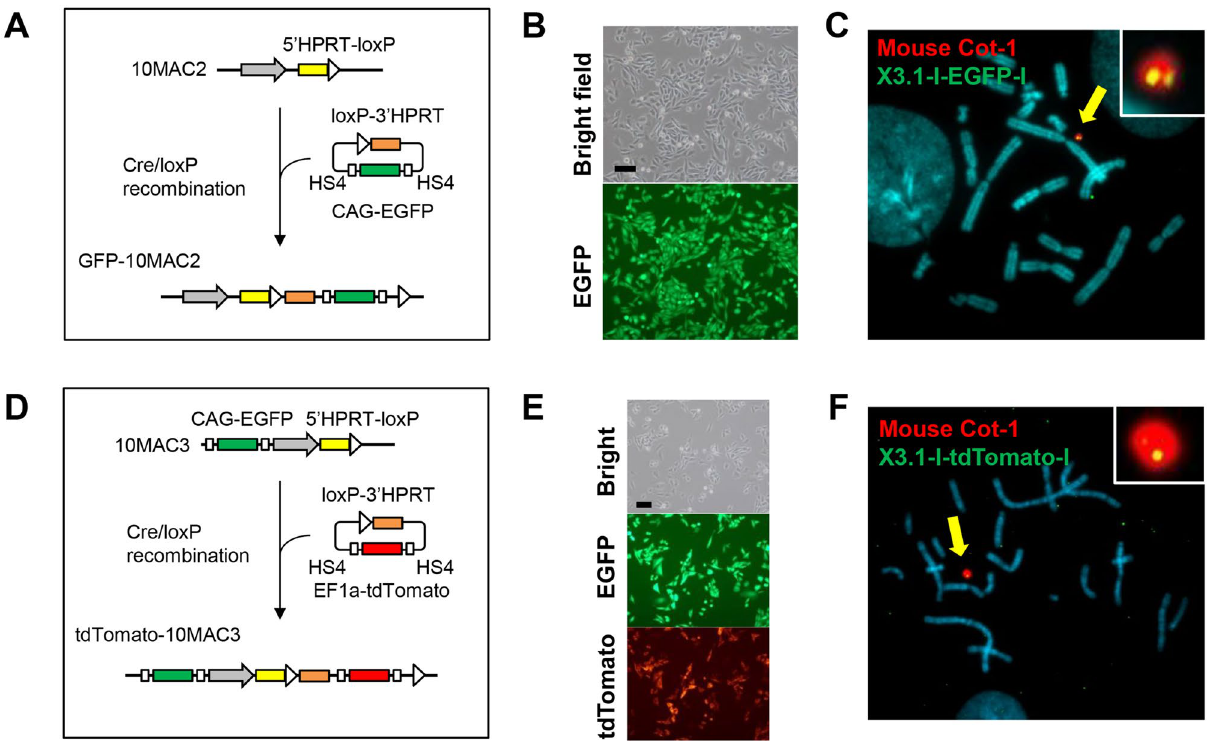
Figure 5. Cre/loxP-mediated gene loading to the 10MAC2 and 10MAC3. (A,D) Strategy for the site-specific insertion of the EGFP and tdTomato genes into the 10MAC2 and 10MAC3 vectors, respectively, using the Cre/ loxP-mediated system in CHO cells. (B) Transfection yielded GFP-expressing HAT-resistant transfectants from the CHO (10MAC2) cells. Phase-contrast (top panel) and fluorescence (bottom panel) micrographs are shown. Scale bar: 100 μm. (C) FISH analysis of the GFP-10MAC2 in the CHO (GFP-10MAC2) cells using the digoxigenin-labeled mouse Cot-1 DNA (red) and the biotin-labeled EGFP gene (green). The arrow indicates the GFP-10MAC2 vector, and the inset shows an enlarged image of the GFP-10MAC2 vector. (E) Transfection yielded tdTomato-expressing HAT-resistant transfectants from the CHO (10MAC3) cells. Phase-contrast (top panel) EGFP (middle panel) and tdTomato (bottom panel) micrographs are shown. Scale bar: 100 μm. (F) FISH analysis of the tdTomato-10MAC3 in the CHO (tdTomato-10MAC3) cells using the digoxigenin-labeled mouse Cot-1 DNA (red) and the biotin-labeled tdTomato gene (green). The arrow indicates the tdTomato-10MAC3 vector, and the inset shows an enlarged image of the tdTomato-10MAC3